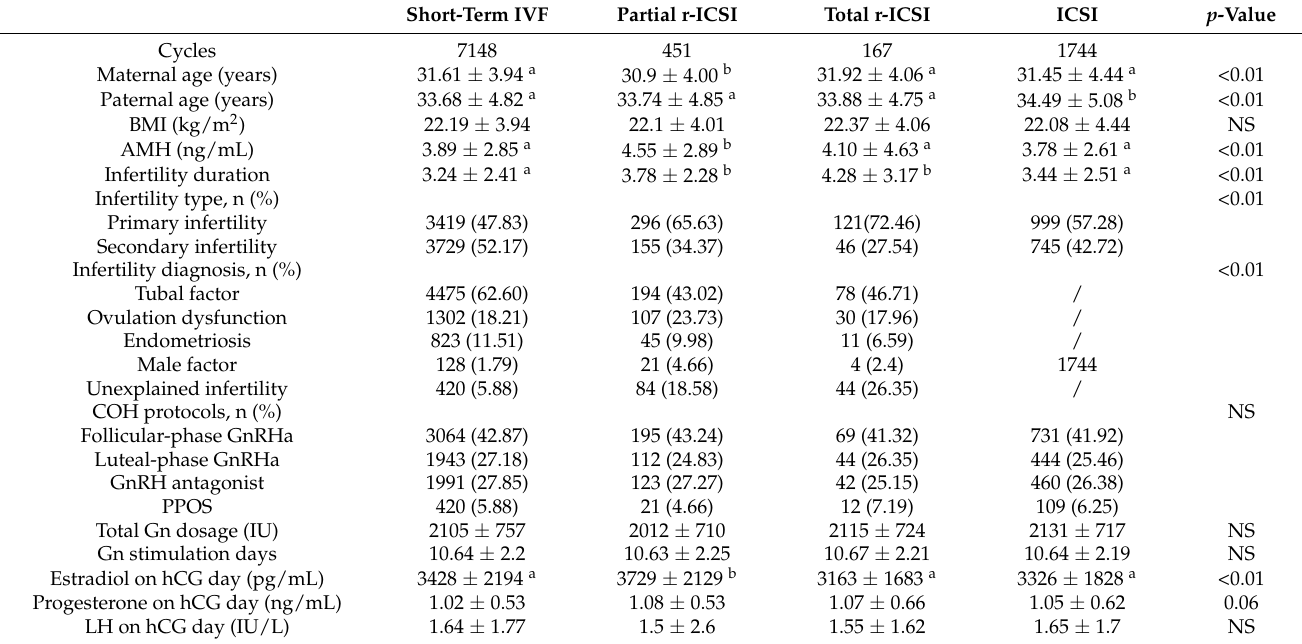
Table 1. Baseline characteristics of couples among four